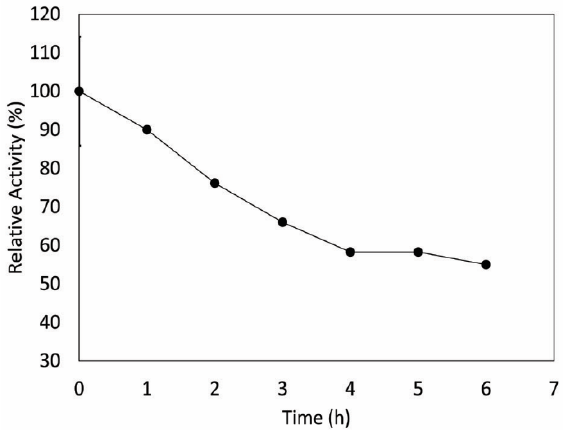
Figure 6. Thermostability of I1P catalase at 50 ◦ C. Measurements were performed at pH 7.0 and 50 ◦ C. Here, 100% of catalase activity represents the maximum activity measured. Measurements were performed in triplicate.